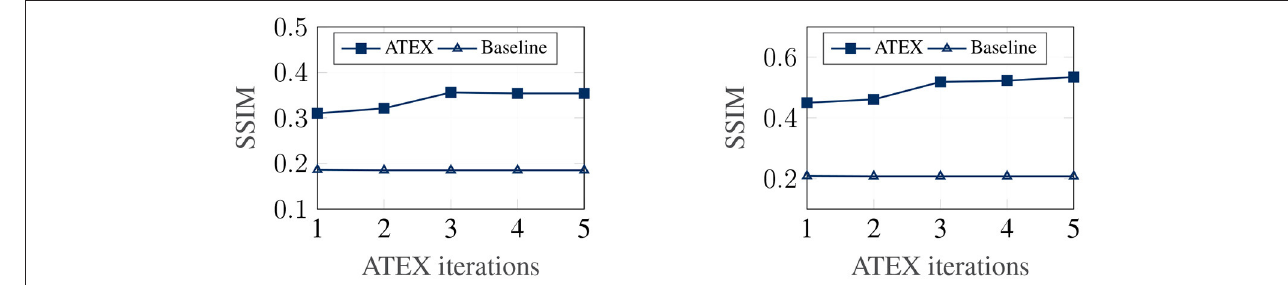
FIGURE 3 | Quantitative evaluation of interpretation smoothness. Left: FashionMNIST. Right: MNIST.